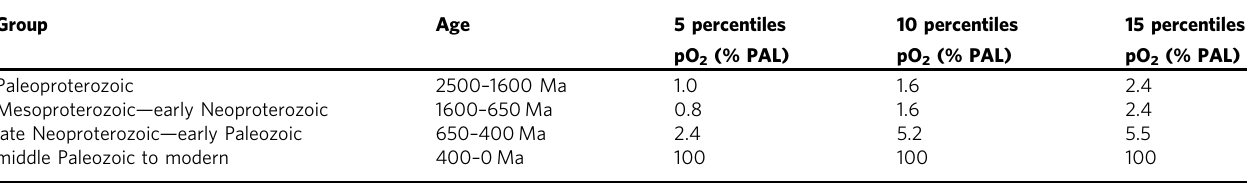
Table 1 Atmospheric oxygen level estimates based on the discrete